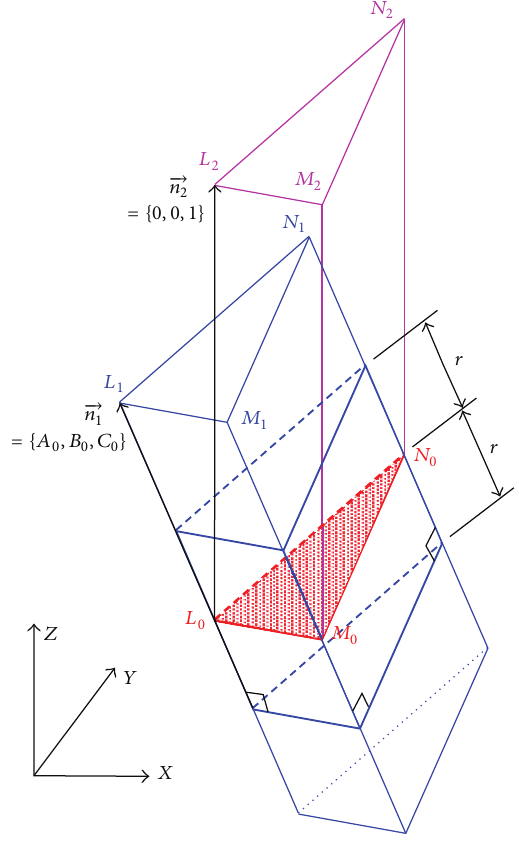
Figure 2: Excavating space of a triangular